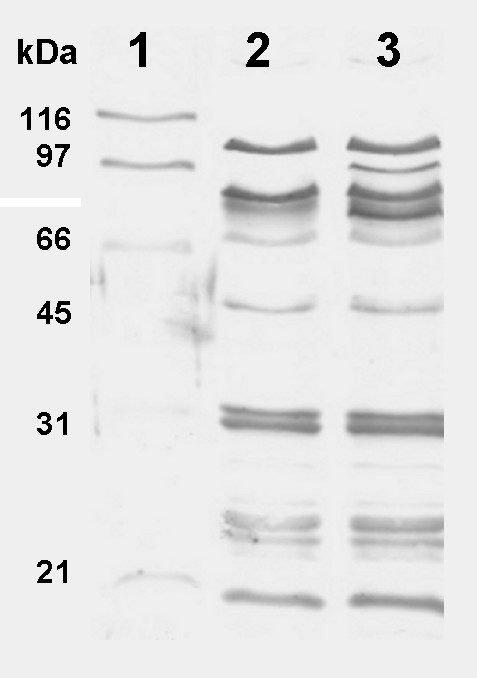
Immunoblot of the total protein fraction of strain 97/241.6Δeae (lane 2) and wild-type strain 97/241.6 (lane 3). A biotinylated broad-range standard (lane 1) was used as a marker (BioRad). The intimin band (~97 kDa), marked with an arrow, is clearly present in the wild-type strain, but absent in the deletion mutant.